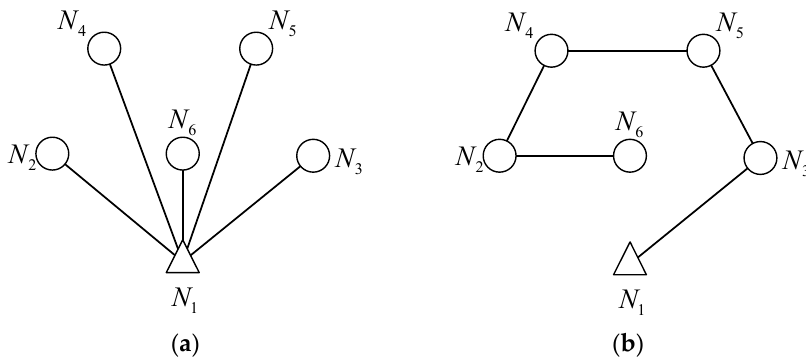
Figure 16. Implementations of fixed topologies in the experiment. ( a ) Star topology; ( b ) chain topology.